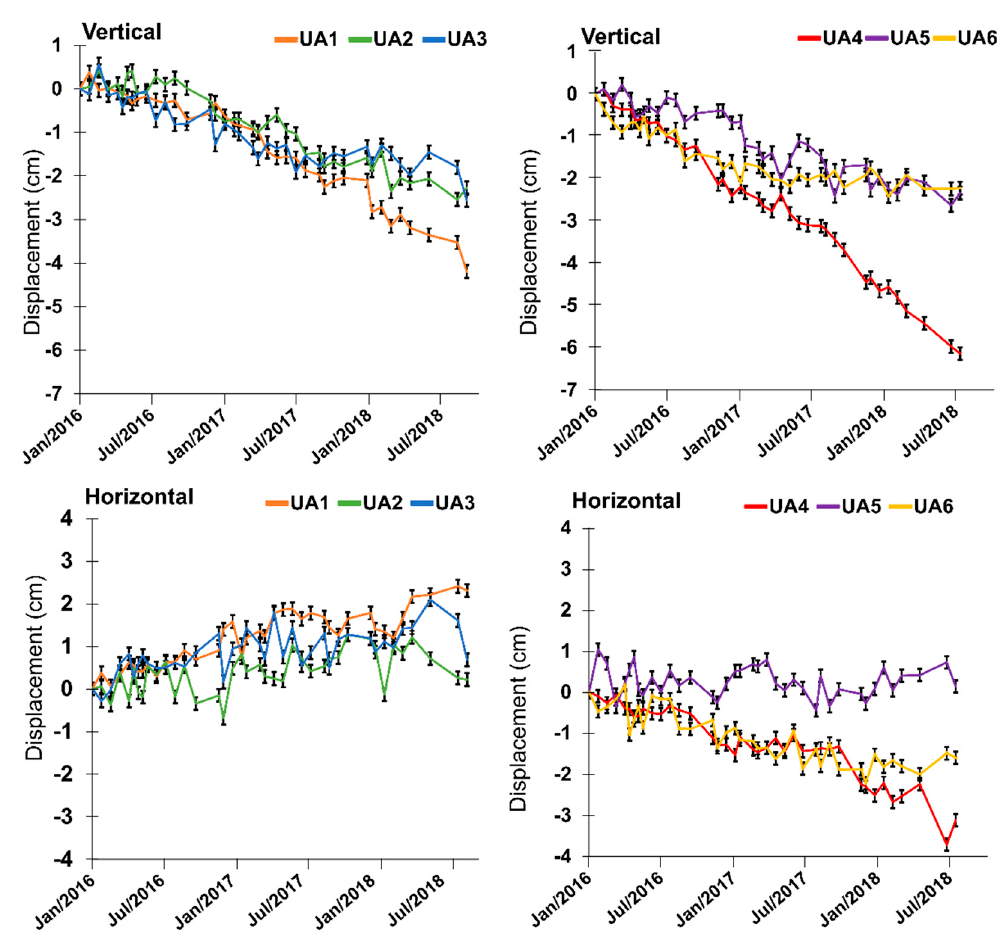
Figure 8. The time series of cumulated vertical and horizontal components. Displacement standard deviation, for each differential interferometric synthetic aperture radar (DInSAR) measurement, are also reported (black).